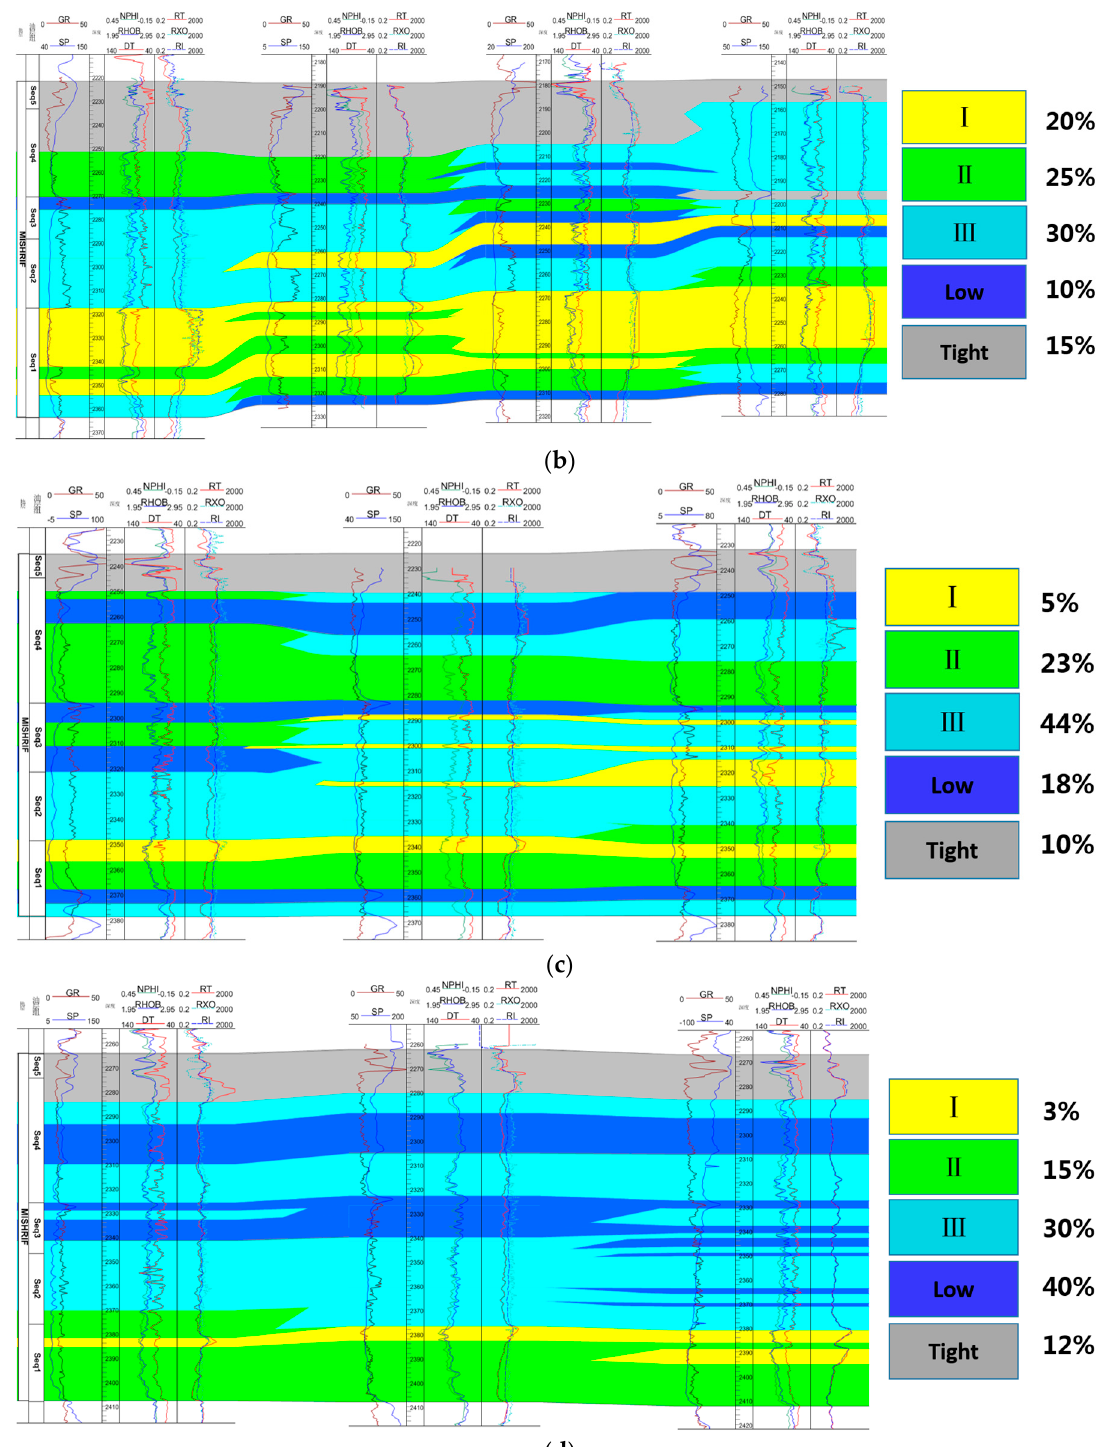
Figure 1. The schematic of four superimposed modes: ( a ) superimposed mode A; ( b ) superimposed mode B; ( c ) superimposed mode C; ( d ) superimposed mode D.